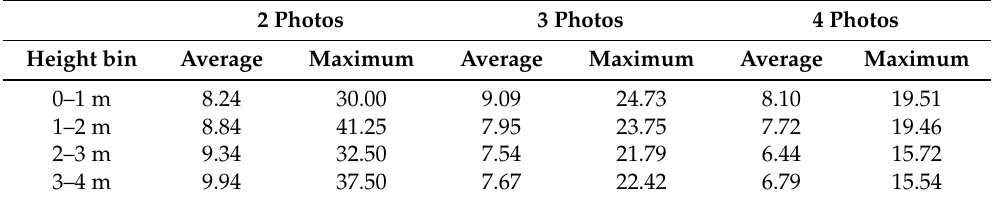
Table 1. Average standard error between measures of percent ladder fuel cover within a given plot and height bin are shown. We report the average standard error for two-, three-, and four-photo samples for each 1 m band in each plot.